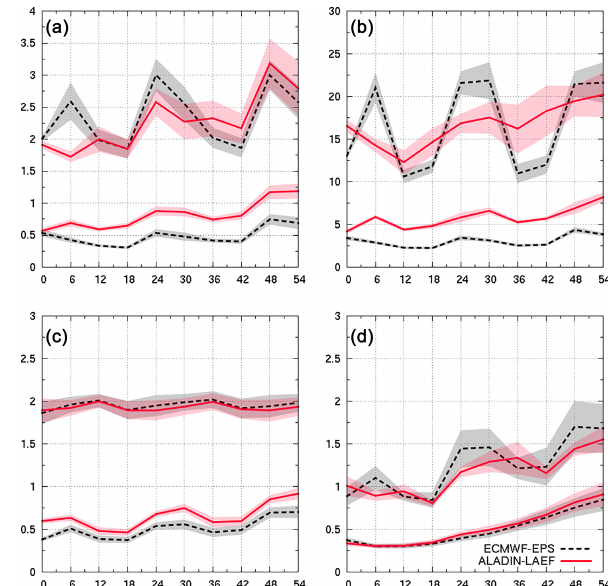
Figure 7. RMSE (upper lines) and spread of 2m temperature (a) , relative humidity (b) , 10m wind (c) and mean sea level pressure (d) versus forecast lead time, calculated against SYNOP observa- tions for ECMWF ENS downscaling (black) and new ALADIN- LAEF Phase I (red). Shading denotes 10% and 90% confidence